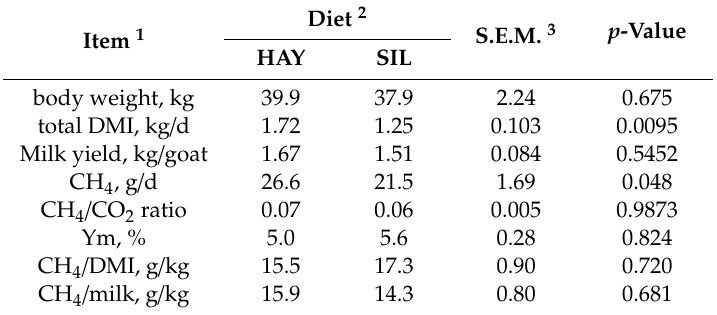
Table 5. Intake (DMI), milk yield, CH 4 emission, breath CH 4 / CO 2 ratio, and CH 4 yield (g / kg) of 8 lactating Murciano-Granadina goats fed HAY (n = 4) or SIL (n = 4) diets.